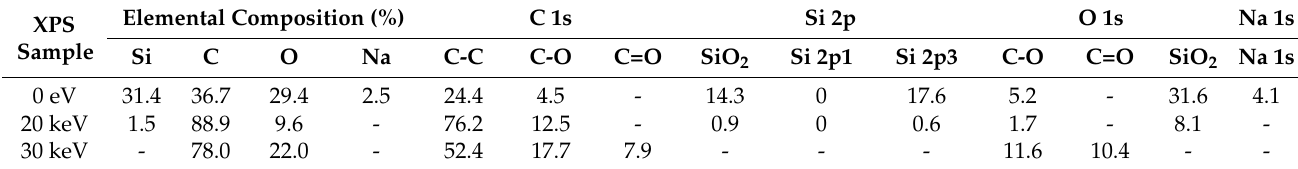
Table 1. Elemental composition (%) of the Si electron lens